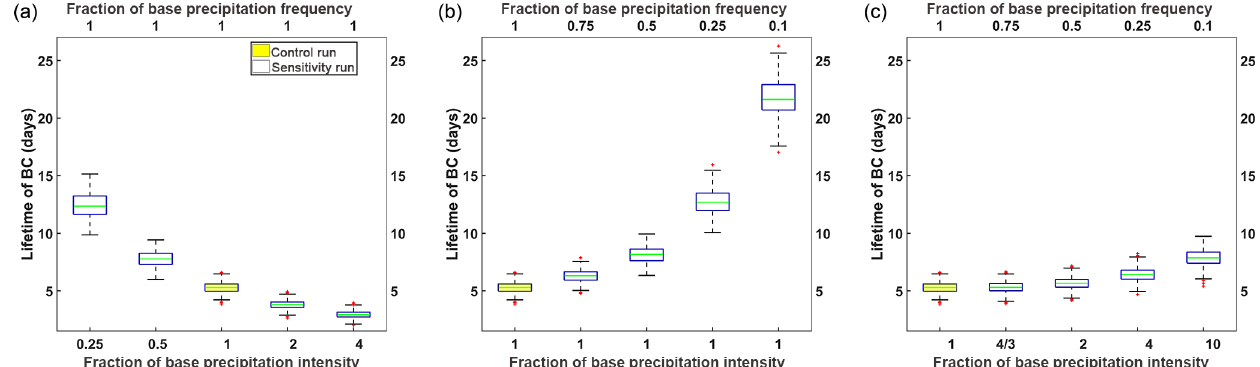
Figure 1. Impacts of the precipitation characteristics on the atmospheric lifetime of BC under a given (a) constant precipitation frequency, (b) constant precipitation intensity, and (c) constant precipitation amount. The top x axis reflects the precipitation frequency set in each perturbation test, shown as fractions of base precipitation frequency. Base precipitation frequency is the precipitation frequency used in the control case. Similarly, the bottom x axis reflects the settings of precipitation intensity in the perturbation tests. The box plot shows the probability distribution of BC lifetime for each case, where the top and bottom edges of each box show the third and first quartiles, respectively; the green central bar shows the median; the whisker shows the range of the non-outliers that cover 99.3% of the data, assuming normally distributed data; and the red plus shows the outliers.